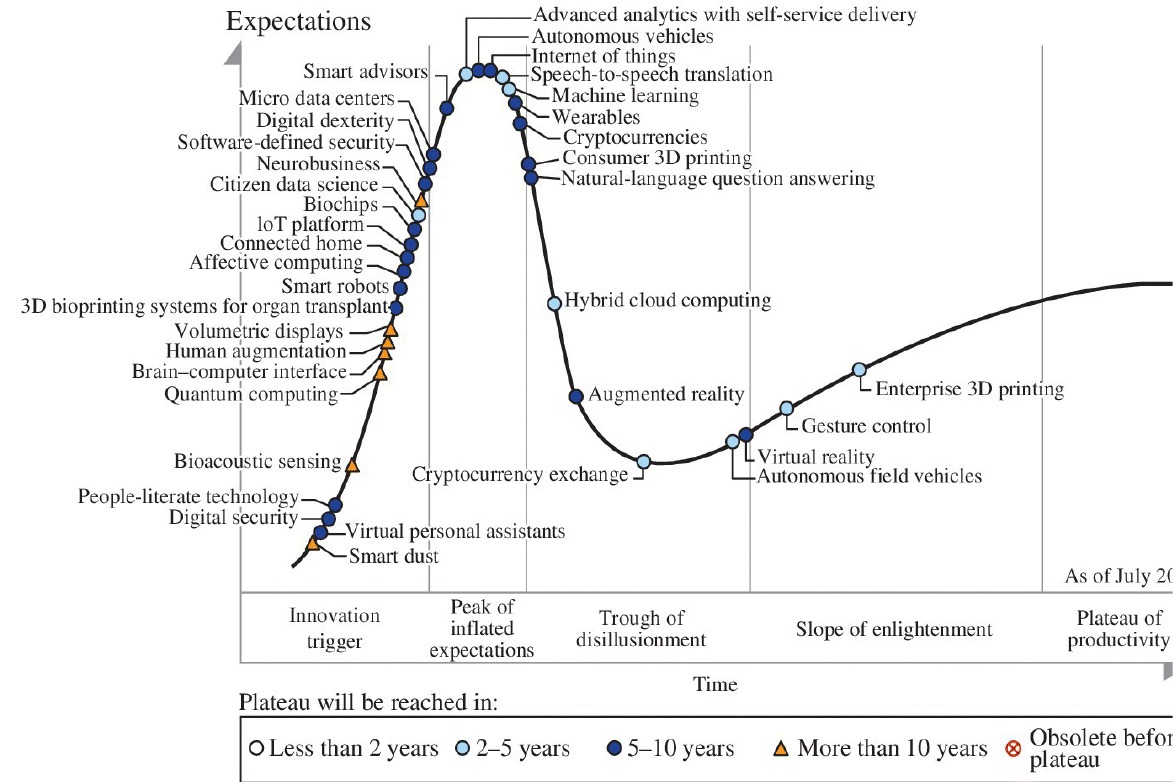
Figure 1 Hype cycle for emerging technologies,